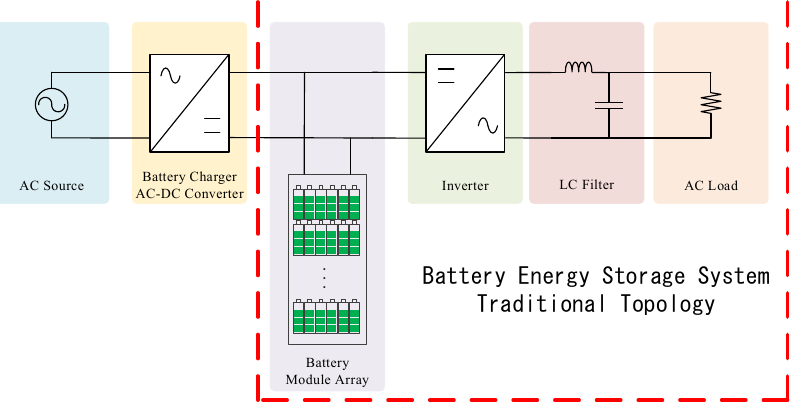
Figure 1. A block diagram of a BESS with a battery charger.